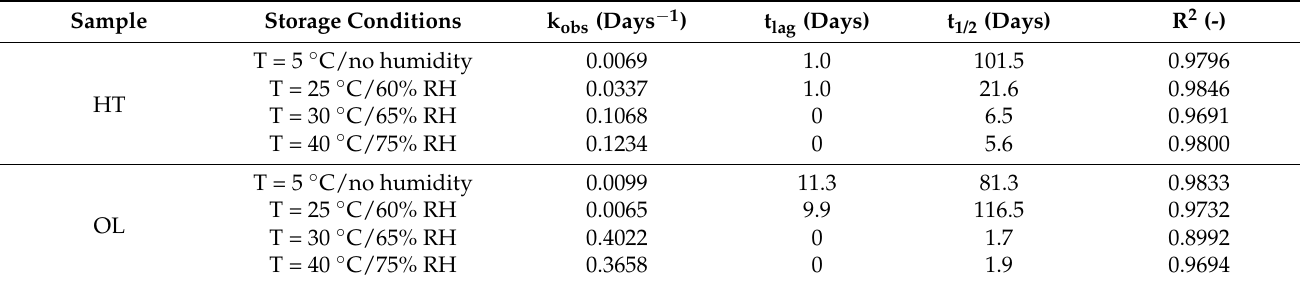
Table 5. Hydroxytyrosol (HT) and Oleuropein (OL) pure aqueous solutions first-order degradation rate constants (k obs ), half-time period (t 1/2 ), and lag time (t lag ) during accelerated stability studies at four different temperature (T)/relative humidity (RH)